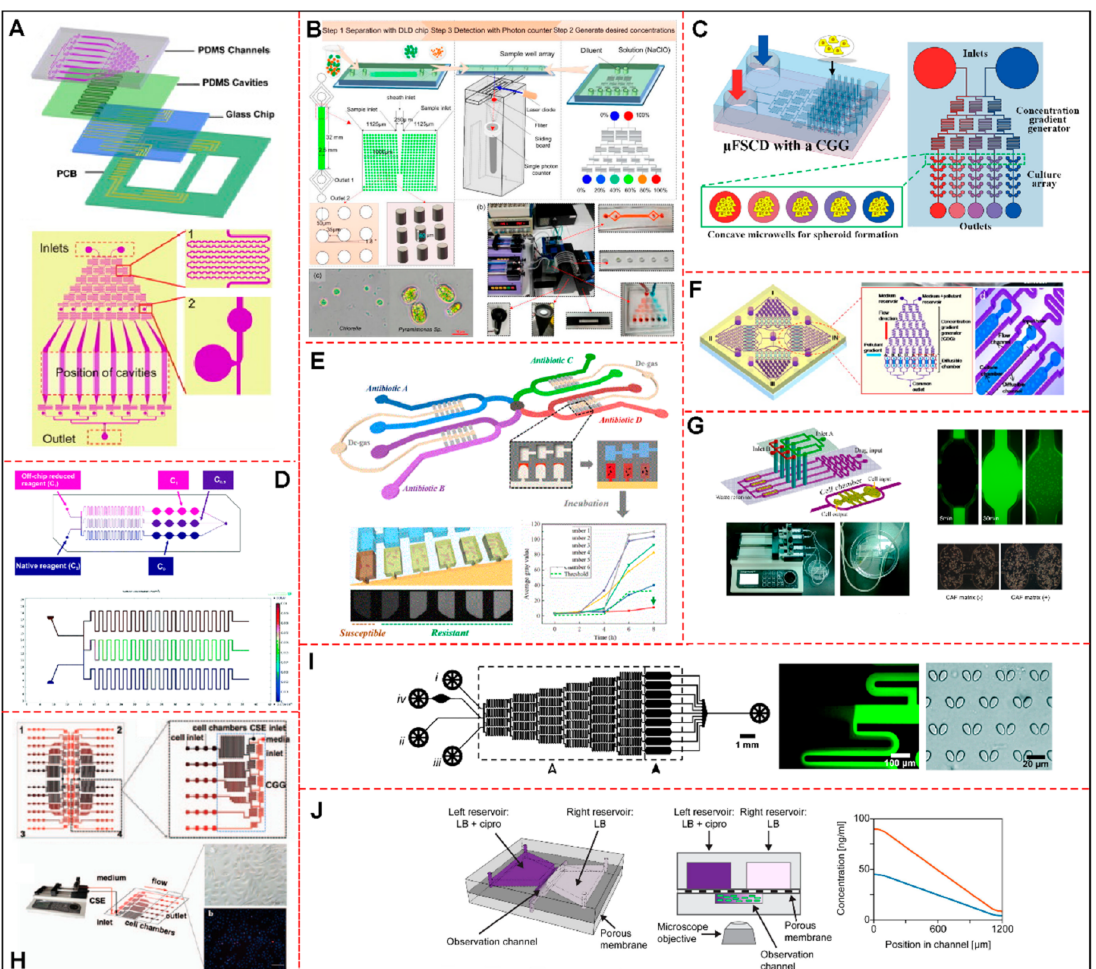
Figure 2. Schematic diagram of microfluidic devices with CGG system for toxicological analysis, representing some of the studies selected in this systematic review. ( A ) Representation of device layers, gradient generator structure, details of fluid mixing units and air bubble valves.